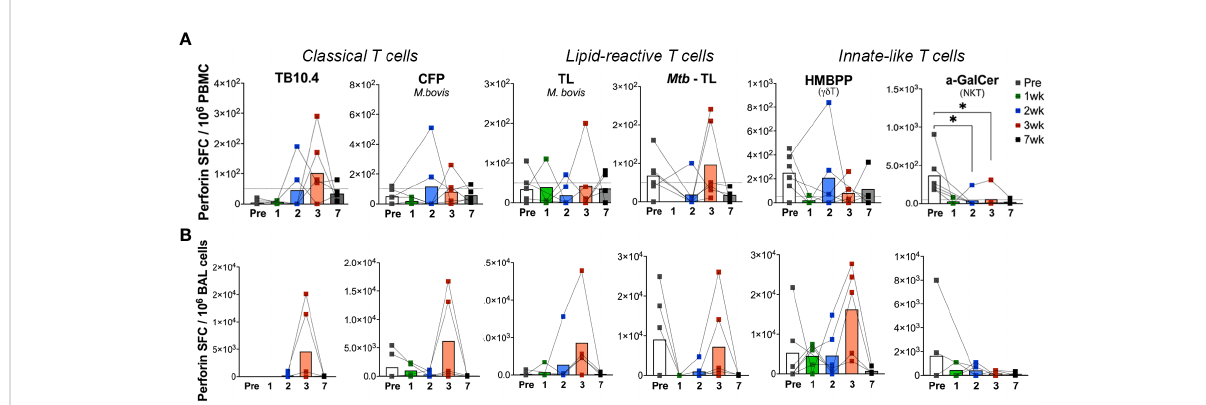
FIGURE 6 Kinetics of peptide- and lipid-reactive Perforin responses in blood and BAL following aerosol BCG exposure. Perforin production expressed as SFU/million cells, following stimulation with TB10.4 peptide pool, M.bovis CFP, M.bovis and Mtb TL fractions, HMBPP, and a -GalCer in freshly isolated (A) PBMCs, and (B) BAL lymphocytes. Pre-BCG inoculation (white bars) and 1wk (green bars), 2wk (blue bars), 3wk post-BCG (red bars), and 7wk (grey bars) time-points were evaluated. Wilcoxon matched pairs signed rank test was used to compute difference between time points with respect to pre-BCG baseline. Asterisks indicate signi fi cant differences between time points (*p <